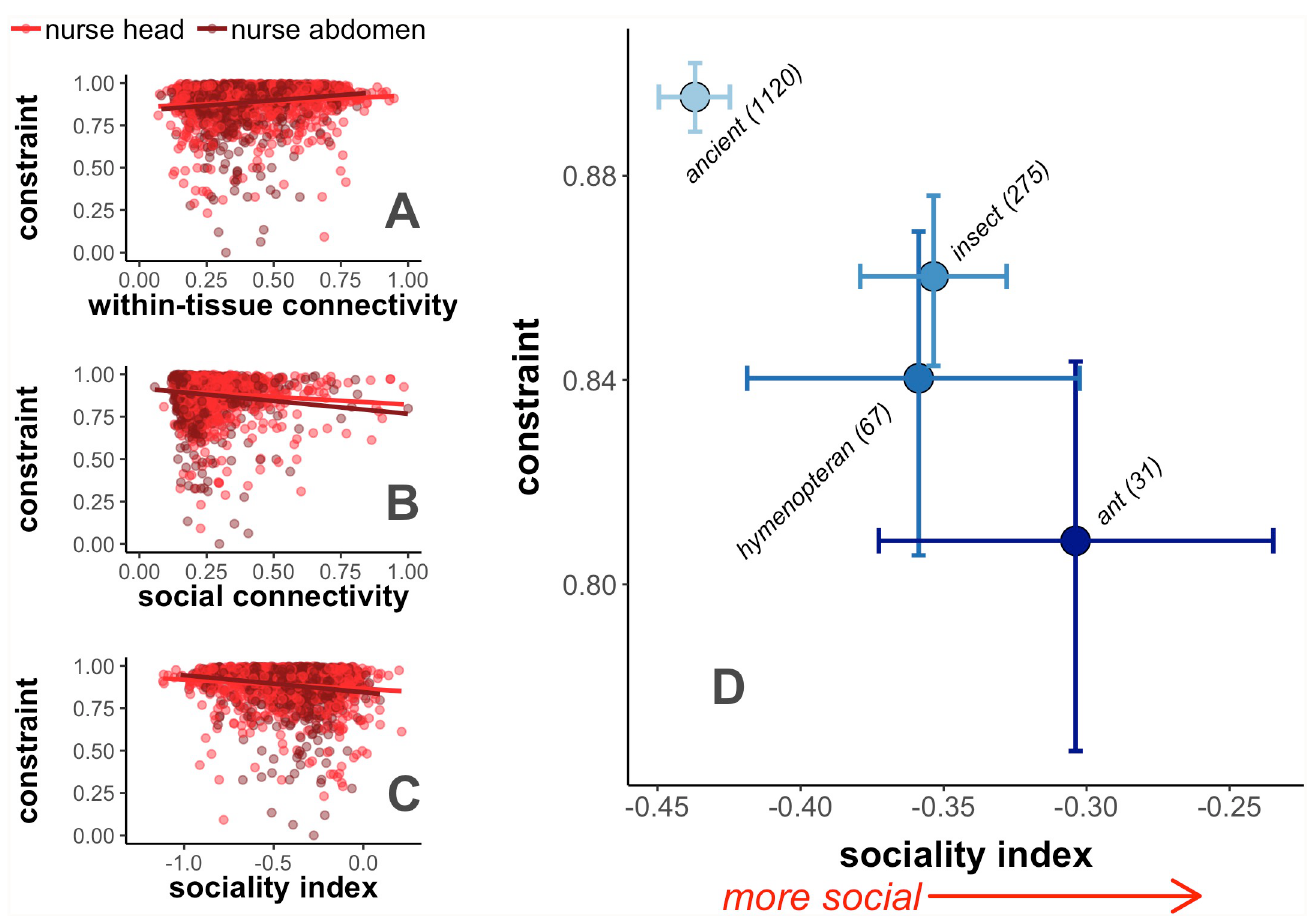
Fig 4. Highly social genes tend to be less evolutionarily constrained. Selective constraint, estimated from whole-genome polymorphism data, is (A) positively correlated with within-tissue connectivity (Spearman correlation; head: rho = 0.122, P < 0.001; abdomen: rho = 0.217, P < 0.001), but negatively correlated with (B) social connectivity (head: rho = -0.090, P = 0.009; abdomen: rho = -0.150, P < 0.001) and (C) sociality index (head: rho = -0.132, P < 0.001; abdomen: rho = -0.223, P < 0.001), where sociality index is the difference between social and within-tissue connectivity per gene. Each point in (A-C) indicates a single gene, as expressed in nurse heads or abdomens. Lines are trendlines from linear model. (D) Sociality index differs according to estimated evolutionary age (GLM; LRT; χ 2 = 57.357, P < 0.001), as ancient genes tended to have lower sociality indices than all other categories (Tukey’s post-hoc test; ancient—insect: P < 0.001, ancient— hymenoptera: P < 0.001, ancient—ant: P < 0.001, all other comparisons P > 0.05). Individual points depict average values across nurse heads and abdomens for all genes within each estimated evolutionary age class, indicated by labels on points. Error bars depict 95% confidence intervals from bootstrapping. Numbers in parentheses indicate number of genes in each age